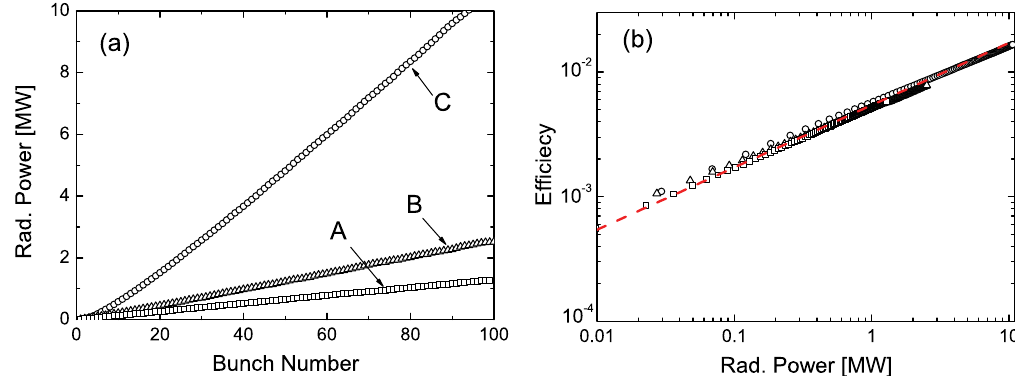
FIG. 3. Power and efficiency evolution for cases A (squares), B (triangles), and C (circles). (a) Average radiation power measured at each bunch. (b) Average energy loss of each bunch as a function of the radiation power. The broken line (in red) is an analytic estimation [Eq. (19)] for a pointlike bunch.